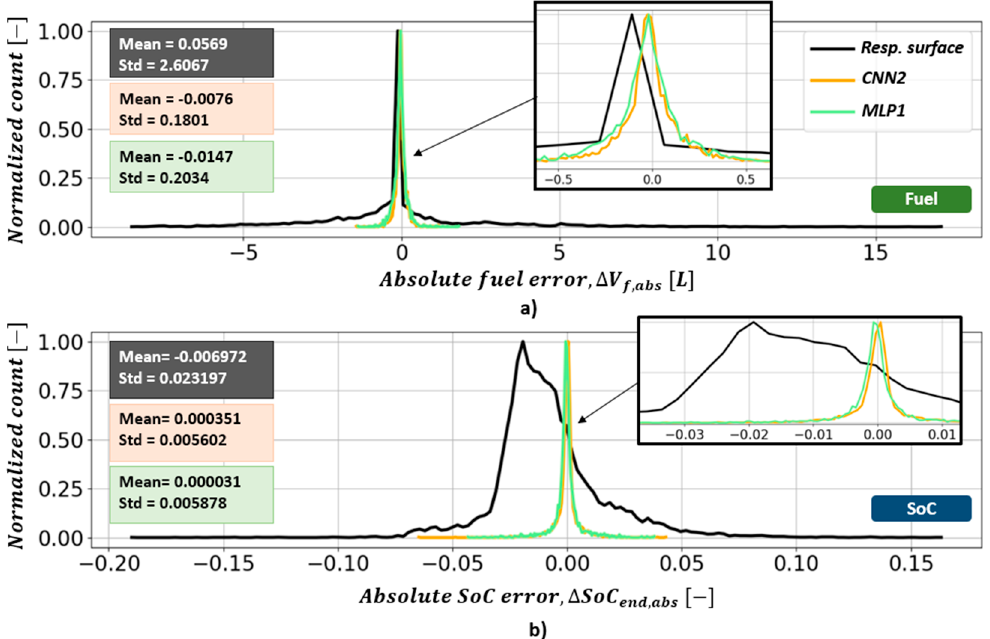
Figure 11. Distribution of normalized absolute residuals of predicted fuel consumptions ∆ V f,abs ( a ) and SoC-at-destinations ∆ SoC end,abs ( b ).